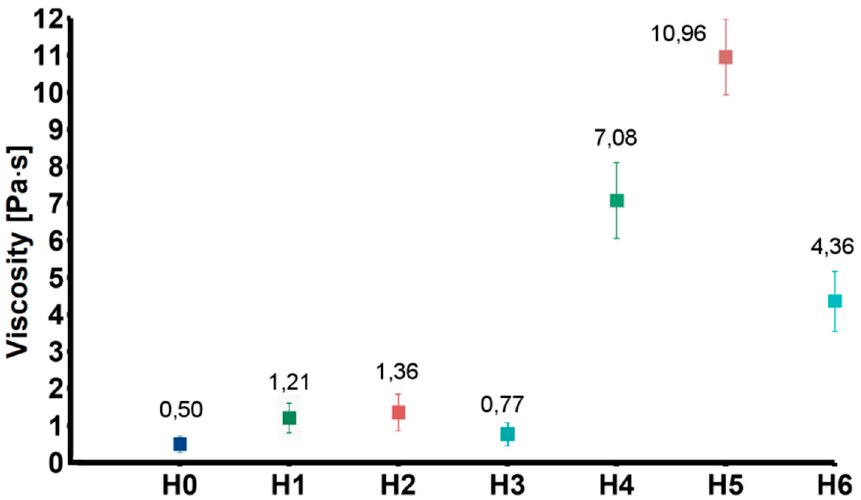
Figure 3. Viscosity of the tested solution (H0: chitosan (CS)) and dispersions (H1: CS / graphene oxide (GO); H2: CS / poly(ethylene glycol) grafted graphene oxide (GO-PEG); H3: CS / reduced graphene oxide (rGO); H4: CS / GO / hydroxyapatite (HAp); H5: CS / GO-PEG / HAp; H6: CS / rGO / HAp).